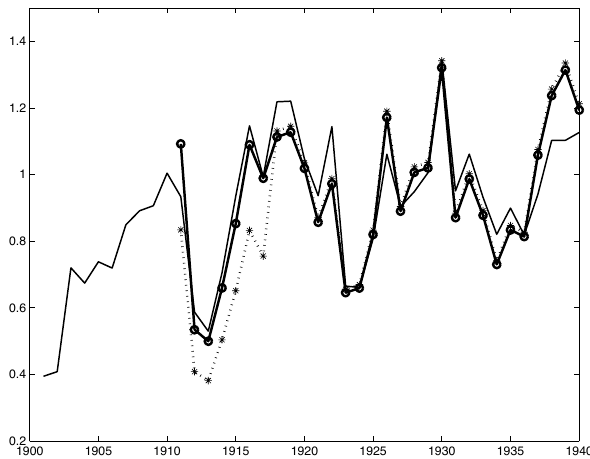
Fig. 6. IHV-raw indices for NGK in 1901–1940 (thin line) and the ESK IHV-raw indices after correction by factors valid for hourly mean values in 1911–1940 (thick line with open circles) and by correction factors valid for hourly spot values in 1911–1917 (dotted line with stars). NGK-ESK comparison suggests that the yearbook ESK data were hourly means, not spot values, even in 1912–1917 while in 1911 they were spot